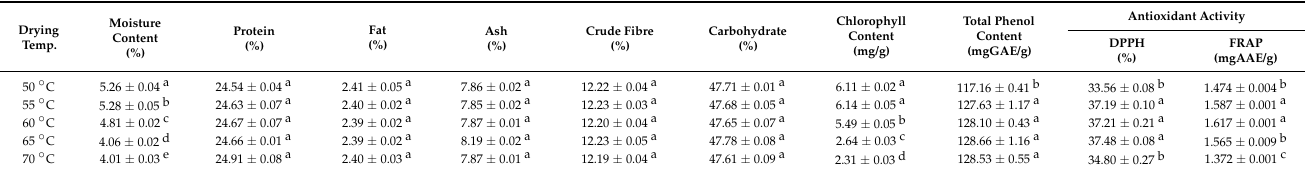
Table 3. Effect of drying temperature on proximate composition, chlorophyll content, total phenolic content, and antioxidant activity of